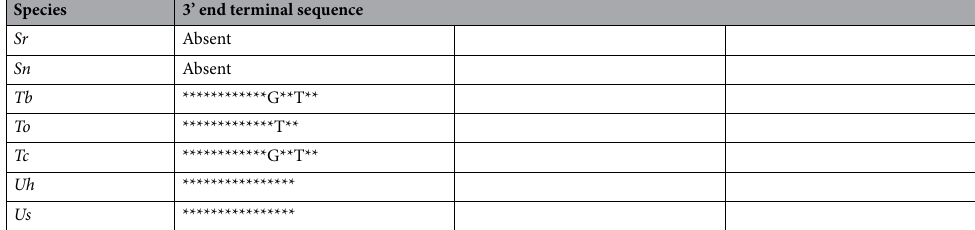
Table 4. The comparison of Central conserved blocks, Conserved sequence blocks and 3’ terminal region in 37 species of Carangidae. Dr = D. russelli, Ac = A. ciliaris, Ai = A. indica, Ad = A. djedaba, Ak = A. kleinii, Am = A. mate, Ca = C. armatus, Cb = C. bajad, Ce = C. equula, Cm = C. malabaricus, Cp = C. plagiotaenia, Ci = C. ignobilis, Ct = C. tille, Cmel = C. melampygus, Dmac = D. macerellus, Dm = D. macrosoma, Dmar = D. maruadsi, Dt = D. tabl, Eb = E. bipinnulata, Gs = G. speciosus, Mc = M. cordyla, Pn = P. niger, Pd = P. dentex, Tt = T. trachurus, Tj = T. japonicas, Sc = S. crumenophthalmus, Sd = S. dumerili, Sl = S. lalandi, Sq = S. quinqueradiata, Sle = S. leptolepis, Sr = S. rivoliana, Sn = S. nigrofasciata, Tb = T. blochii, To = T. ovatus, Tc = T. carolinus, Uh = U. helvola, Us = U. secunda. Asterisks indicate the same nucleotide as the reference sequence. Insertions are represented as bold and deletions as underlined. Other nucleotides denote base